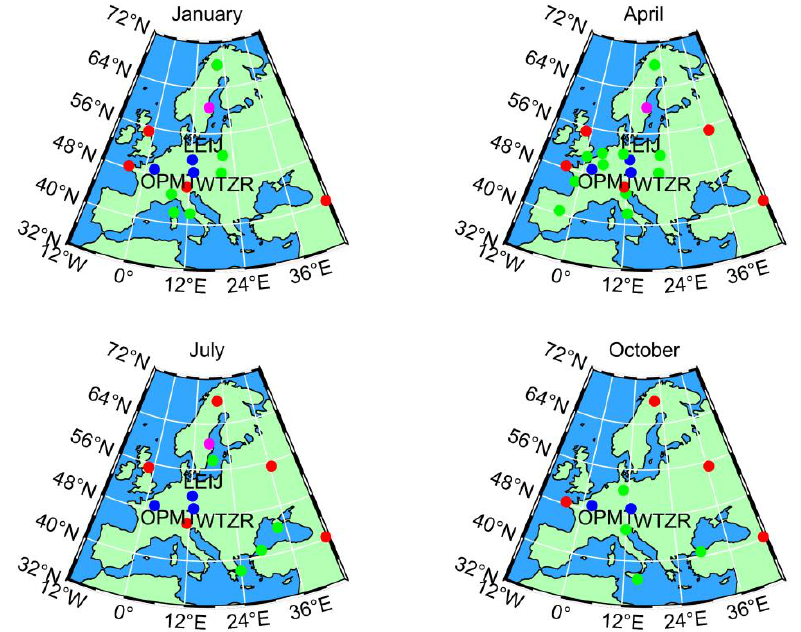
Figure 13. Station distribution based on the conditions of improvement rate < 0, and | average cosine | < 0.2. These spots with different color correspond with the colored spots in Figure 12.